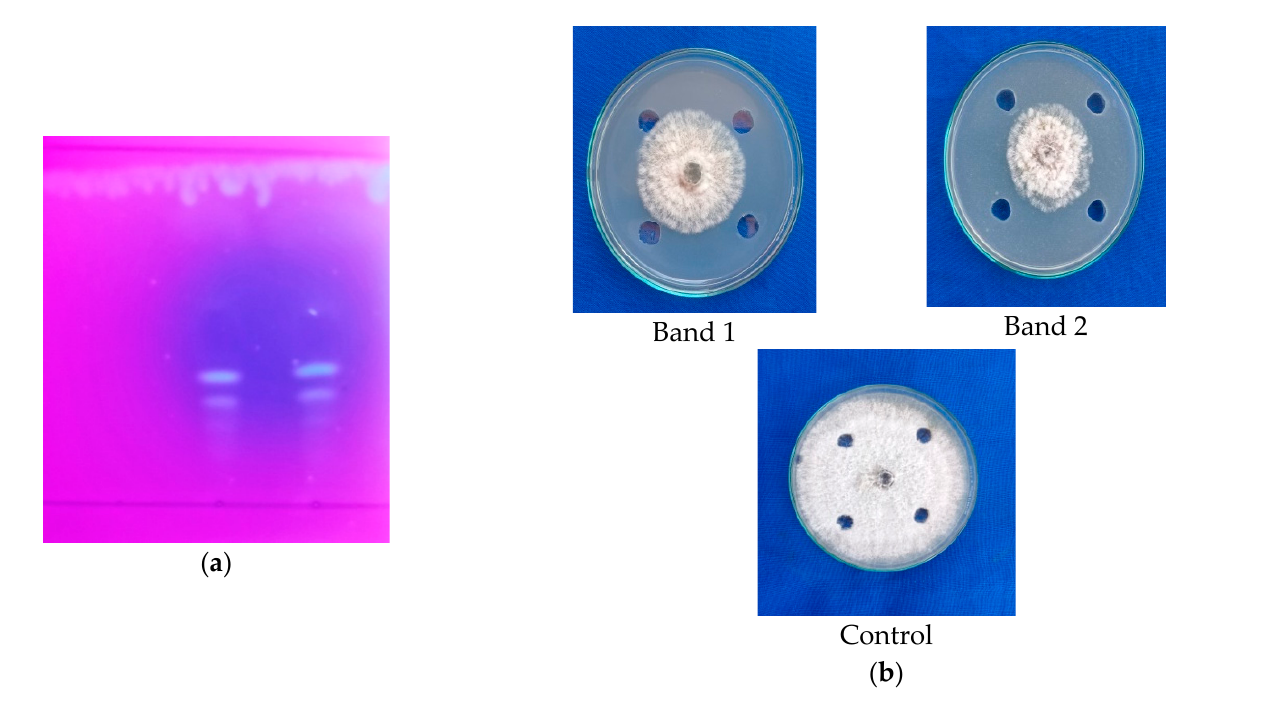
Figure 4. ( a ) Detection of antimicrobial compounds by ethyl acetate extracts from the fruiting body of G. lucidum (cap) through TLC; ( b ) antimicrobial activity of compound eluted from TLC. Table 2. Testing the antimicrobial activity of compounds eluted from TLC band of G. lucidum (ex- Further, the bands (band 1 and band 2) were eluted. The antifungal activity of eluted extract from the bands was tested against C. gloeosporioides using the agar well tracts from fruiting body) against mycelial growth of C. gloeosporioides.